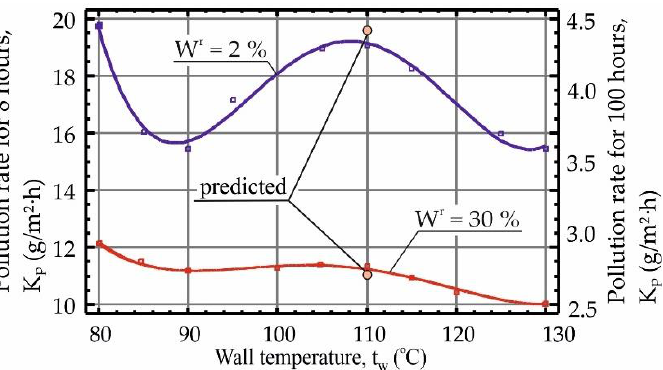
Figure 11. Dependences of pollution rate K p on wall temperature t w during the fuel oils and WFE combustion.